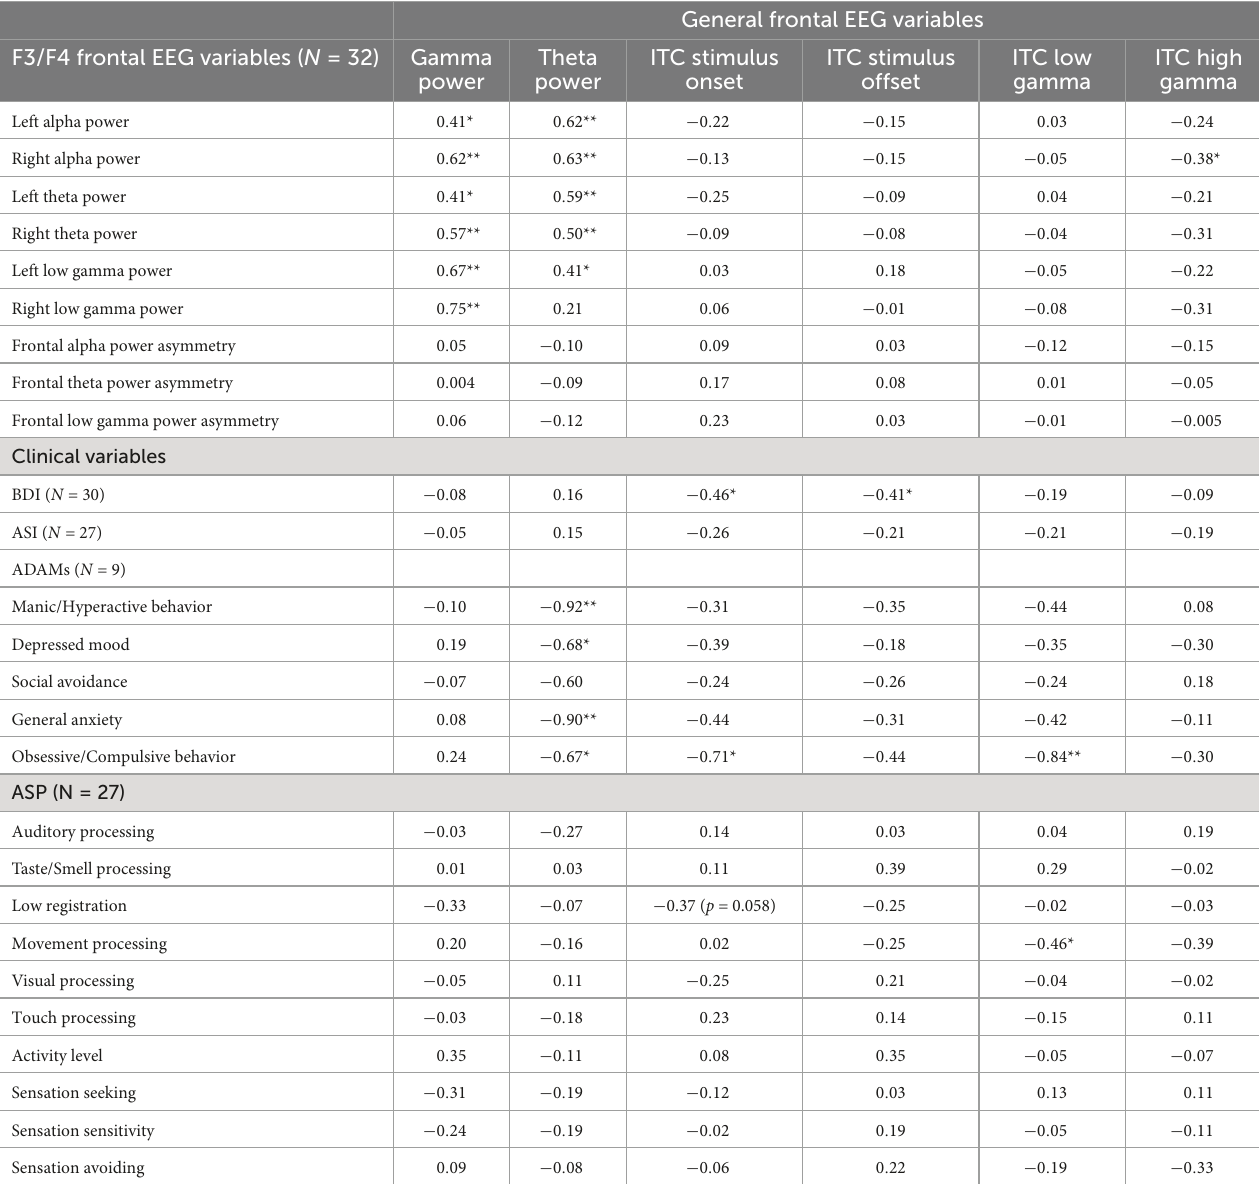
TABLE 4 Correlations between general frontal EEG variables, F3/F4 frontal EEG variables, and clinical variables for PMCs.